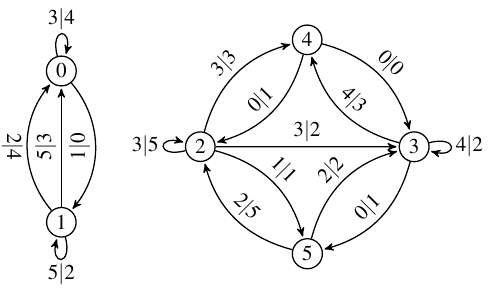
Figure 12. Transducer graph of the Ammann set of 16 Wang tiles over 6